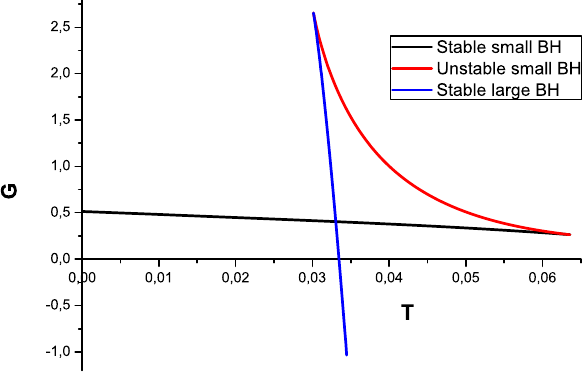
Fig. 7 Gibbs for p = 0 . 00001 < p